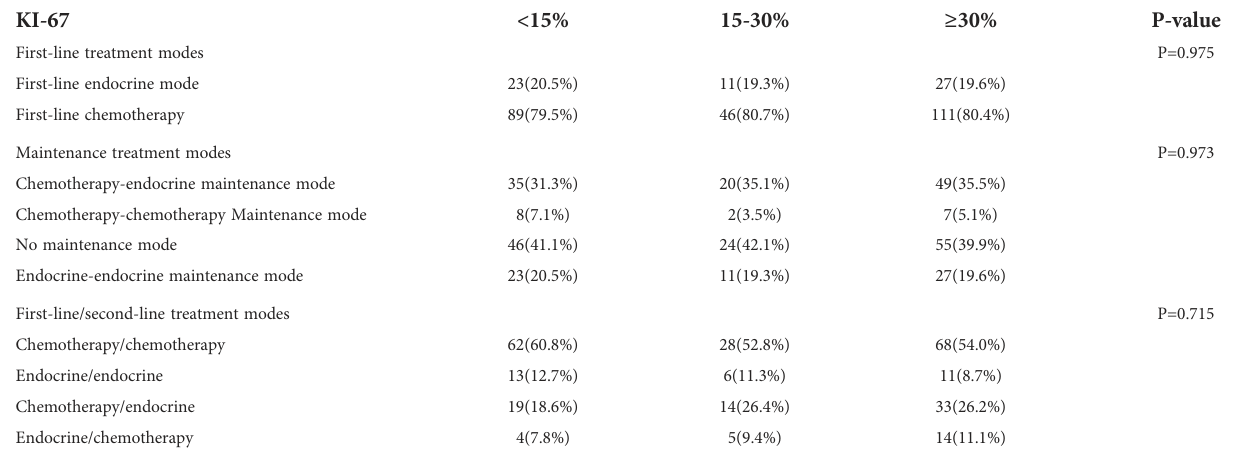
TABLE 2 Distribution of the expression of Ki-67 in different treatment